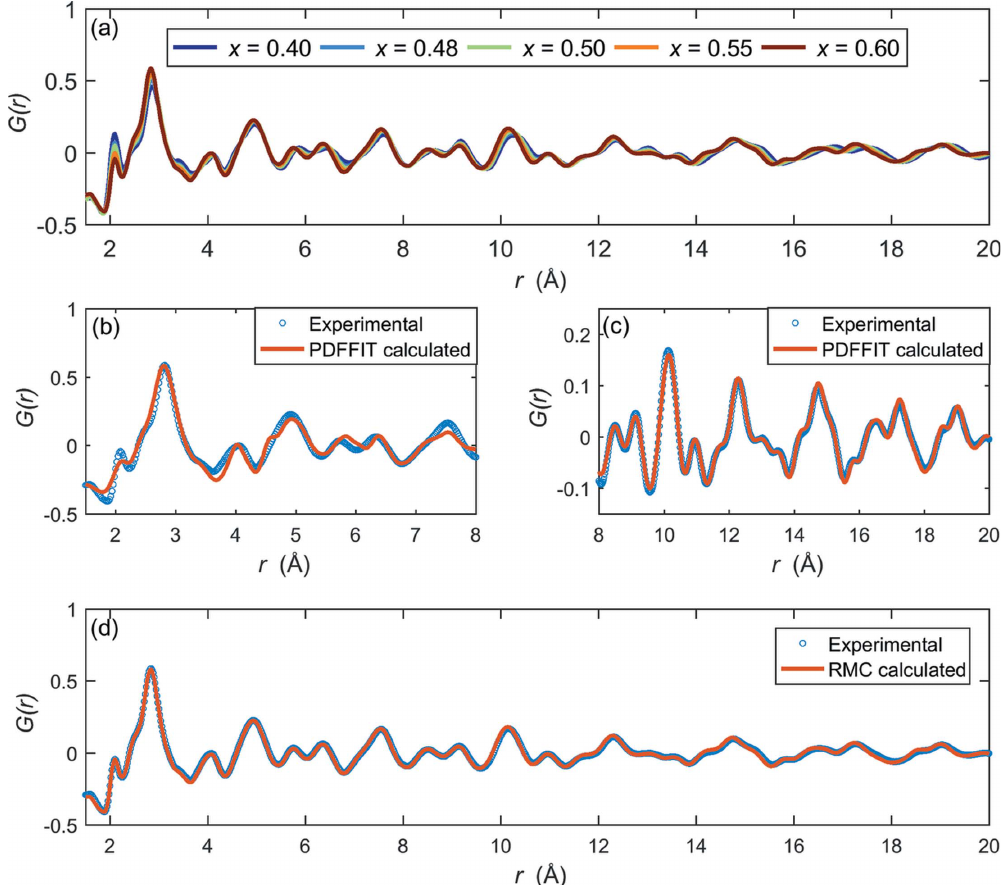
Figure 1 ( a ) PDF data for PZT x = 0.40–0.60. ( b ), ( c ) Small-box modelling of the PZT x = 0.60 (tetragonal) PDF data using PDFFIT . The fitting range is restricted to 1.5–8 A˚ as very short-range and 8–20 A˚ , respectively. ( d ) Big-box modelling of the PZT60 (tetragonal) PDF data using the RMC